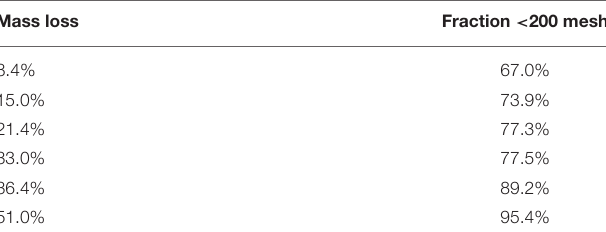
TABLE 5 | Fraction < 200 mesh of torrefied material in various mass